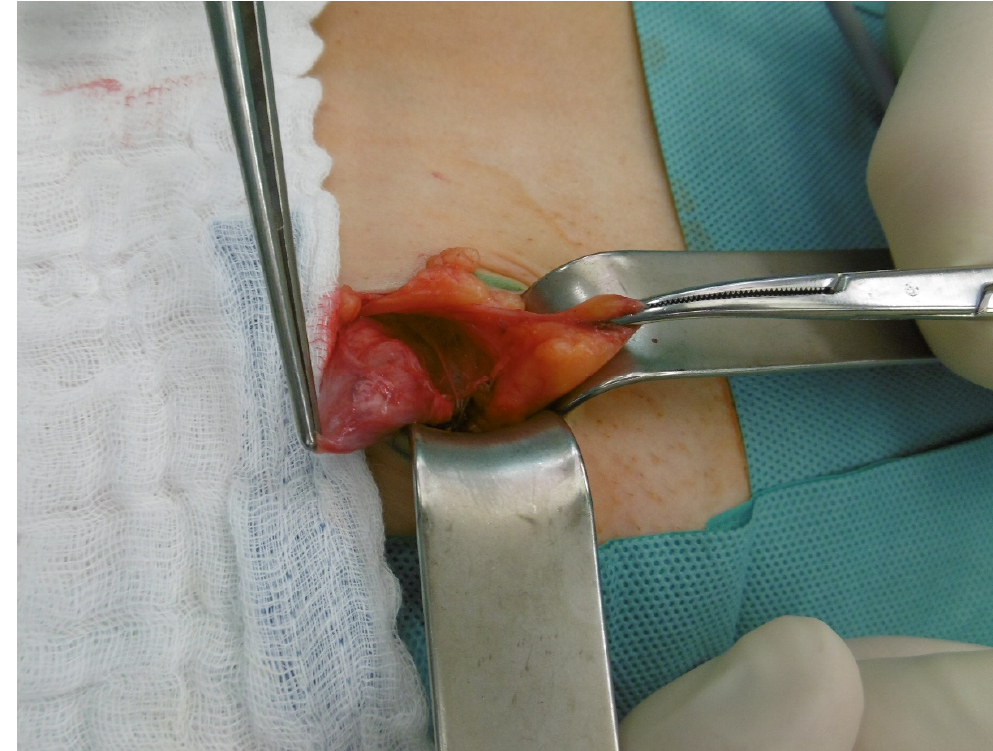
Figure 2. Intraoperative picture of the cyst of the canal of Nuck after dissection from the round ligament.